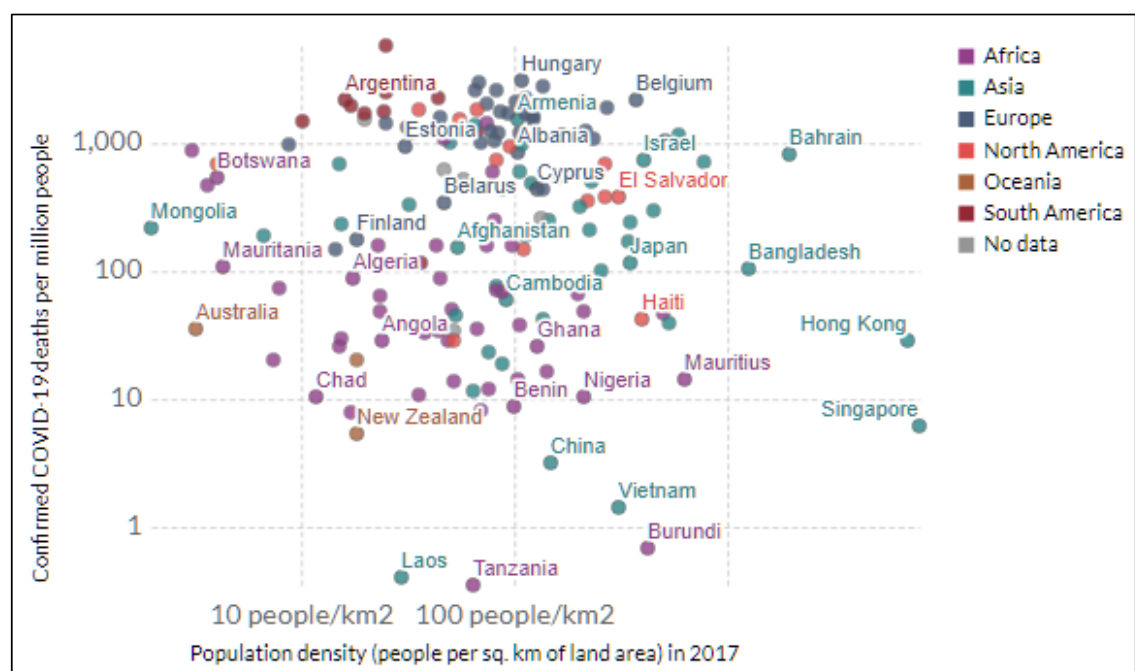
Figure 3. COVID-19 deaths versus population density based on data from 22 January to 14 July; time 20:03 London time. (data source: www.ourworldindata.org/Coronavirus-death accessed 13 July 2021; Ritchie et al., [10]). Note: countries with a < 1 million population are excluded from the visualization.